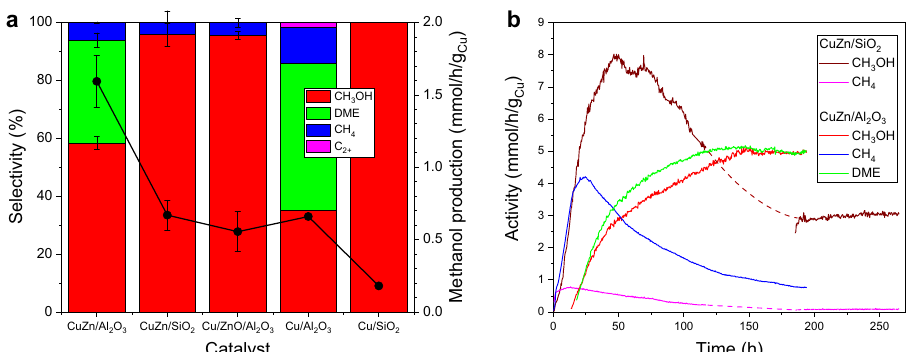
Fig. 5 Catalytic performance and evolution of the reaction products during the activation. a Comparison of the methanol production and overall selectivity of all catalysts at 250°C and 40 bar. The C 2 + products are mainly C 2 H 6 . Error bars represent standard deviation. b Temporal evolution of the main reaction products of the CuZn/SiO 2 and CuZn/Al 2 O 3 catalysts at 40 bar and 280°C during an activation treatment until the steady state was achieved. The dashed lines serve as a guide for the